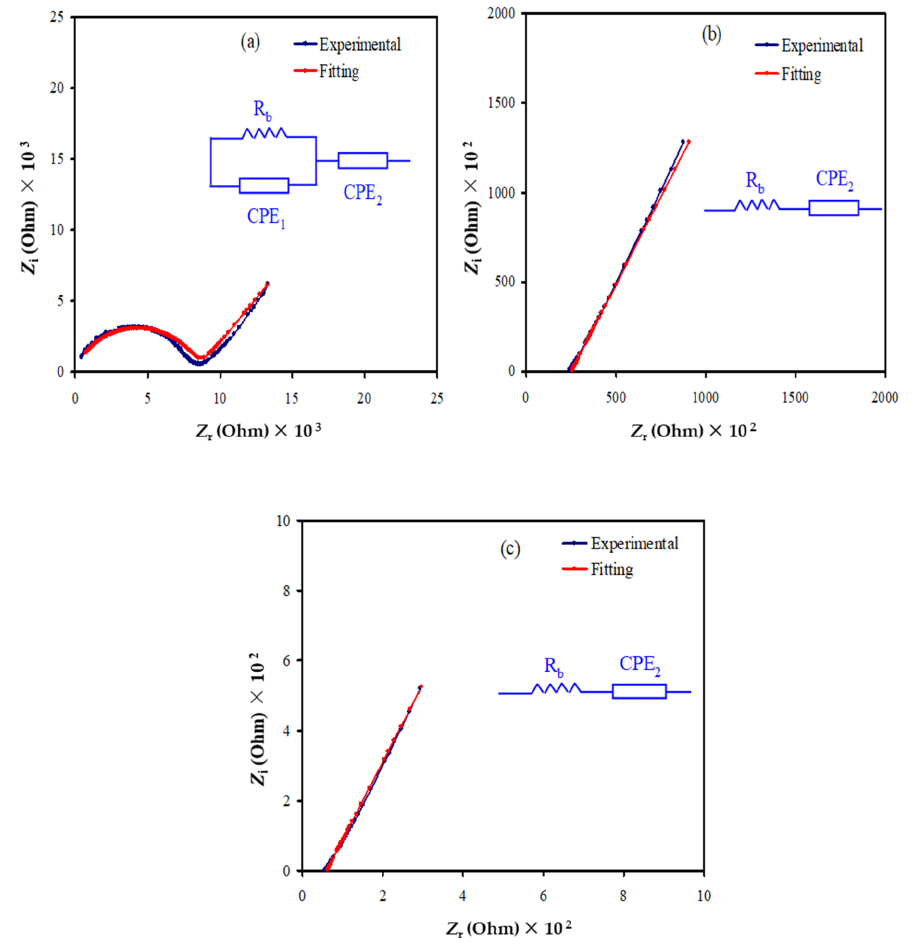
Figure 3. Electrochemical impedance spectroscopy (EIS) plots for the ( a ) CSDNHP1, ( b ) CSDNHP2, and ( c ) CSDNHP3 electrolyte films. Table 1. Direct current ( DC) conductivity for the plasticized electrolyte system at room temperature.